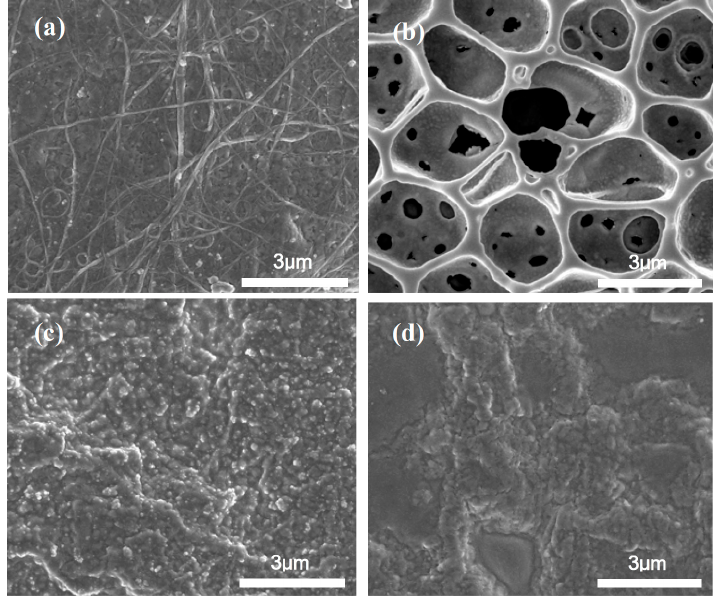
Figure 9. SEM morphology of polymer/MWCNT composite films after the test ( a ) MWCNT film; ( b ) EC/MWCNT film; ( c ) PEO/MWCNT film; and ( d ) PVP/MWCNT film.